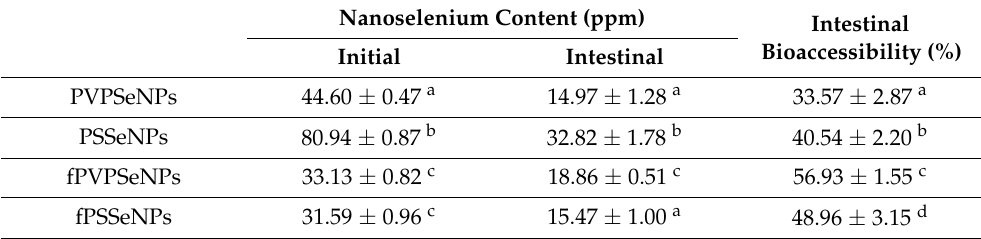
Table 2. Gastrointestinal stability and bioaccessibility of SeNPs.